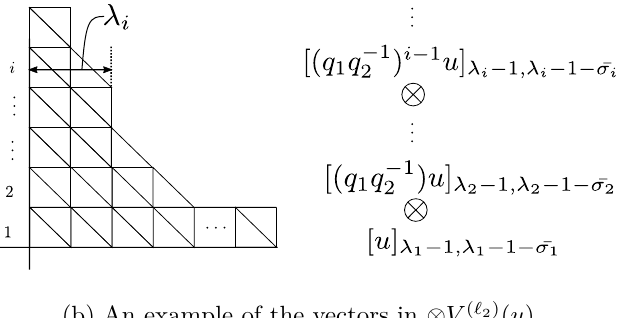
Figure 23. Generalization of Young diagram and tensor products. (a) [ u ] triangles, while [ u ] has λ blue and λ − 1 red triangles in the right of the border. (b) Triangle ( λ, 1) partition model [64] can be obtained by taking tensor products of [( q